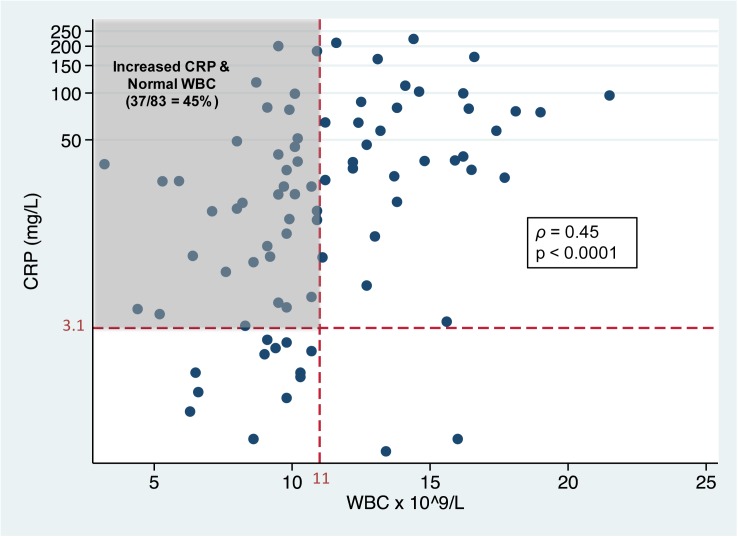
Scatterplot of admission (day 0) C-reactive protein (CRP) levels and WBC count.CRP and WBC are significantly correlated but 45% of pulmonary exacerbation events are characterized by an elevated CRP (>3.1 mg/L) and normal WBC (<11 x 109 cells/L).